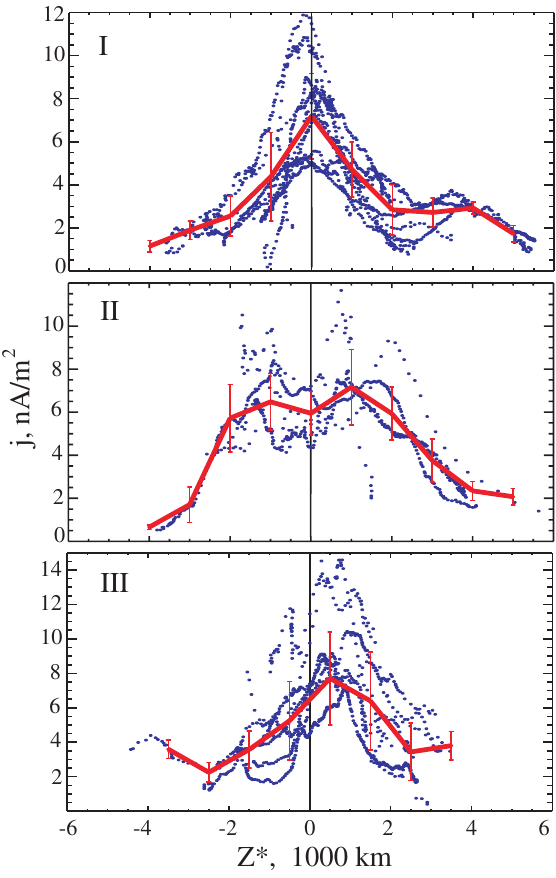
Fig. 4. Averaged vertical profiles of the current density for center peaked (class I), bifurcated (class II), and asymmetric (class III) current sheets. The Z* is calculated using Eq. (3).